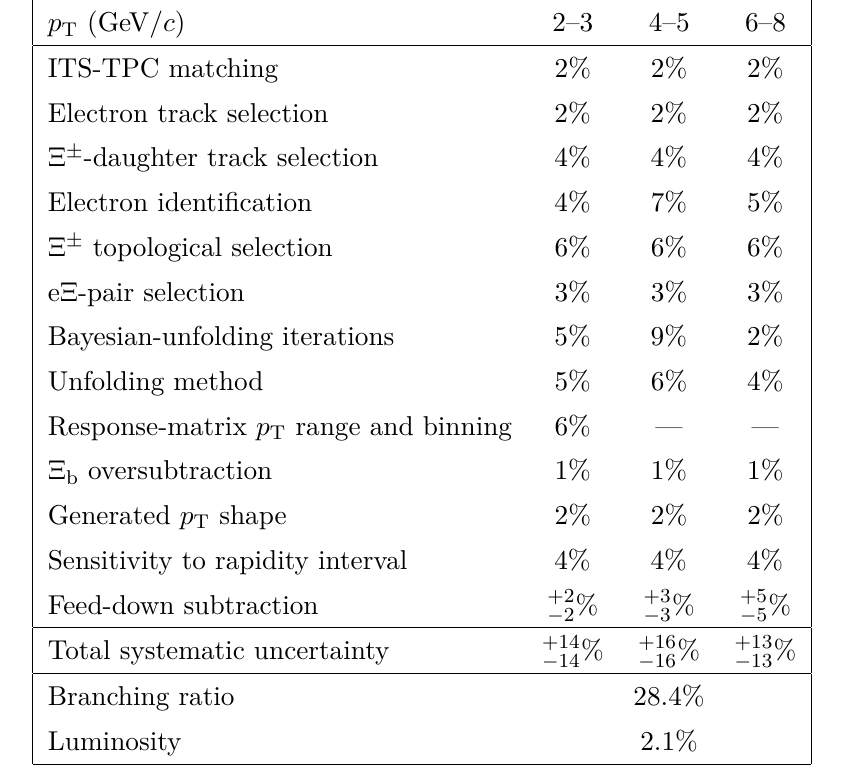
Table 1 . Contributions to the systematic uncertainty of the Ξ 0 2 < p T < 3 GeV/ c , 4 < p T < 5 GeV/ c , and 6 < p T < 8 GeV/ c